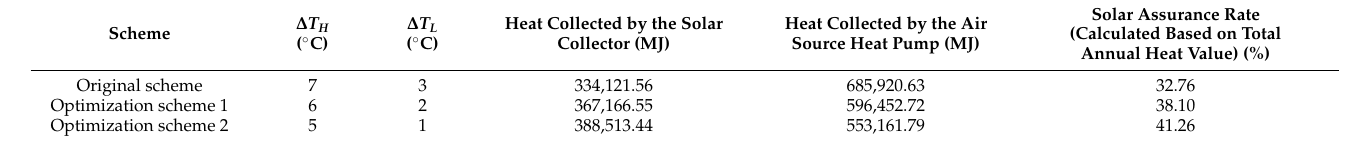
Table 4. Comparison of main parameters after optimization of operation control